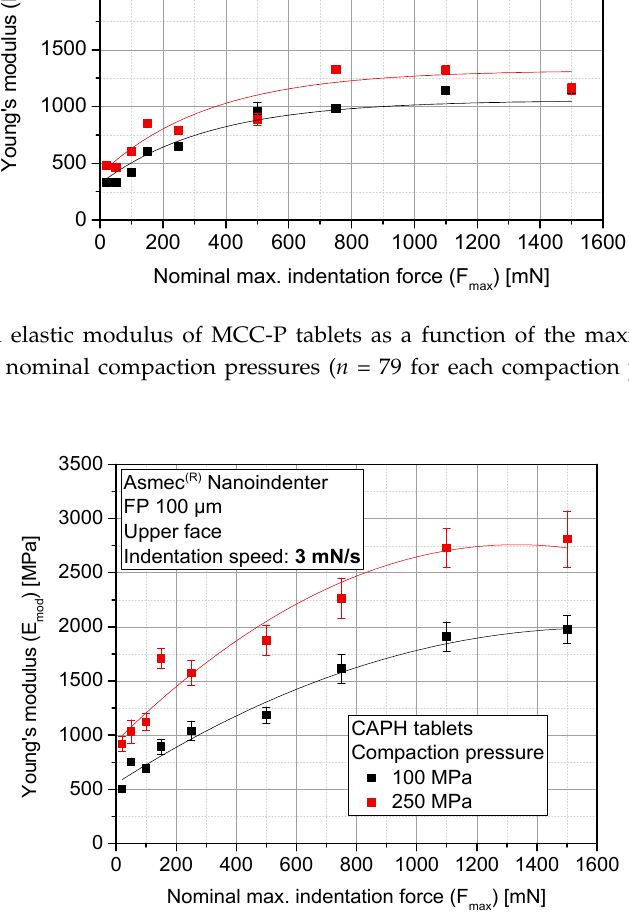
Figure 9. Median elastic modulus of CAPH tablets as a function of the maximum indentation force for different nominal compaction pressures ( n = 79 for each CP and indentation force).